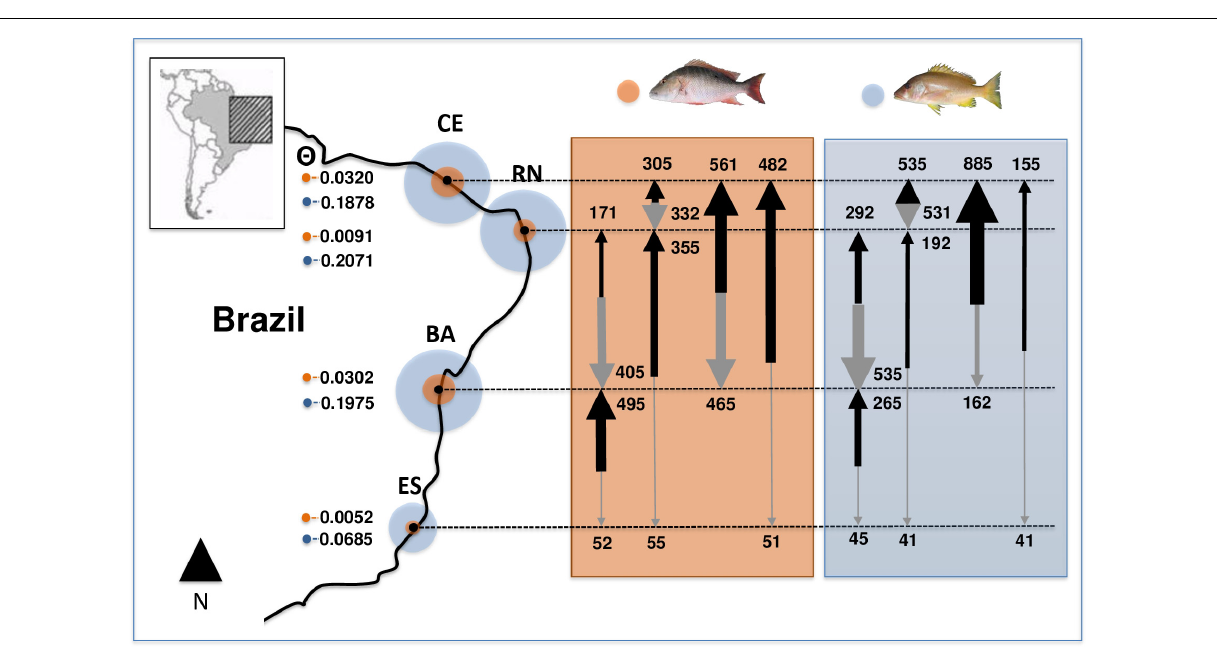
FIGURE 2 | Effective population sizes (median estimates of θ ; proportional to circles size) and migration rates among populations of Lutjanus analis (orange circle) and Lutjanus jocu (blue circle). Arrows represent migration rates, with arrow boldness being relative to the estimate of